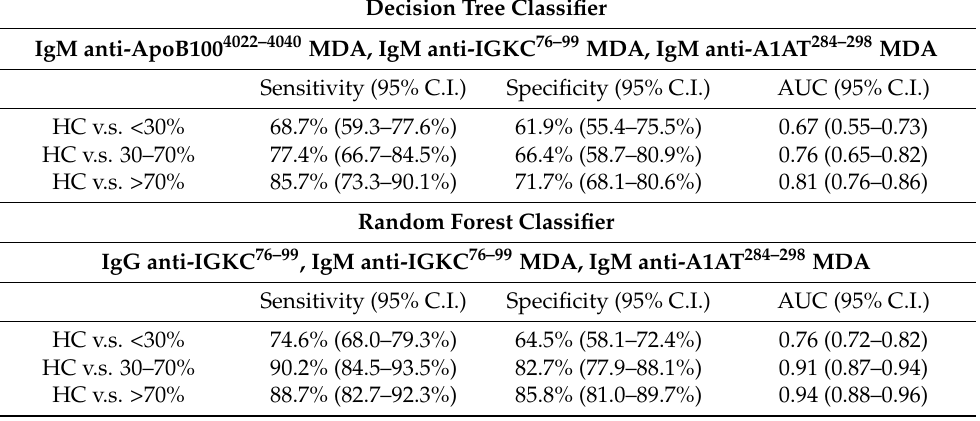
Table 3. Comparison of AUC, sensitivity, and specificity of autoantibody isotypes against unmodified and malondialdehyde (MDA)-modified peptides in CAD patients compared to HCs with a decision tree classifier ( A ) and random forest classifier ( B